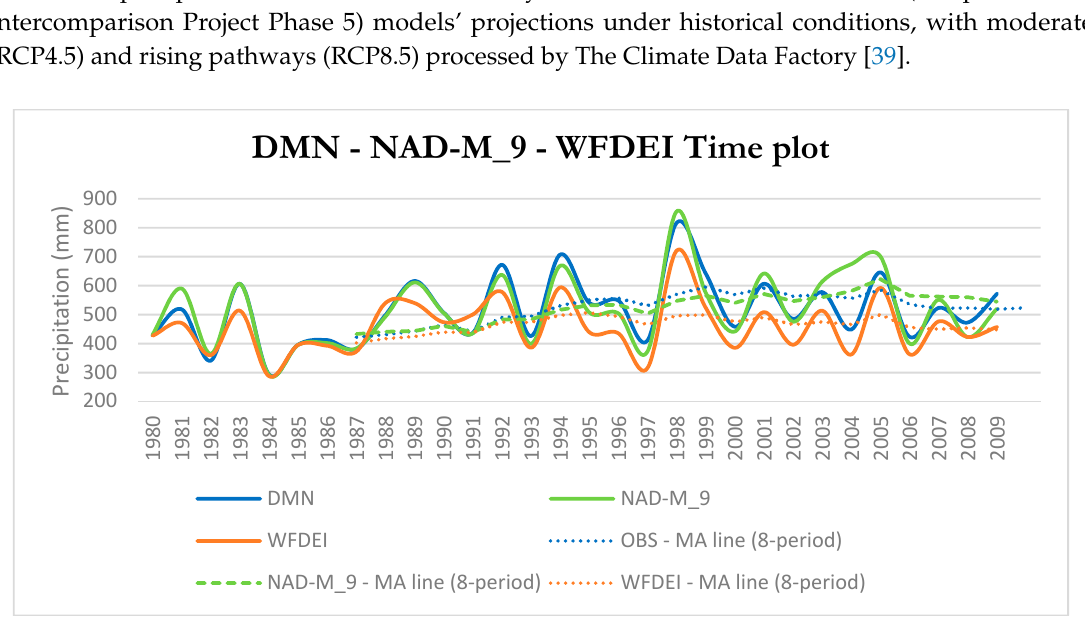
Figure 2 . Cumulative annual time plot for DMN and NAD-M_9 datasets and WATCH-Forcing-Data-ERA-Interim (solid line) and 8-period (8 year) Moving Average (dashed line). Table 5. Descriptive statistics of DMN, NAD-M_9 datasets and WATCH-Forcing-Data-ERA-Interim.